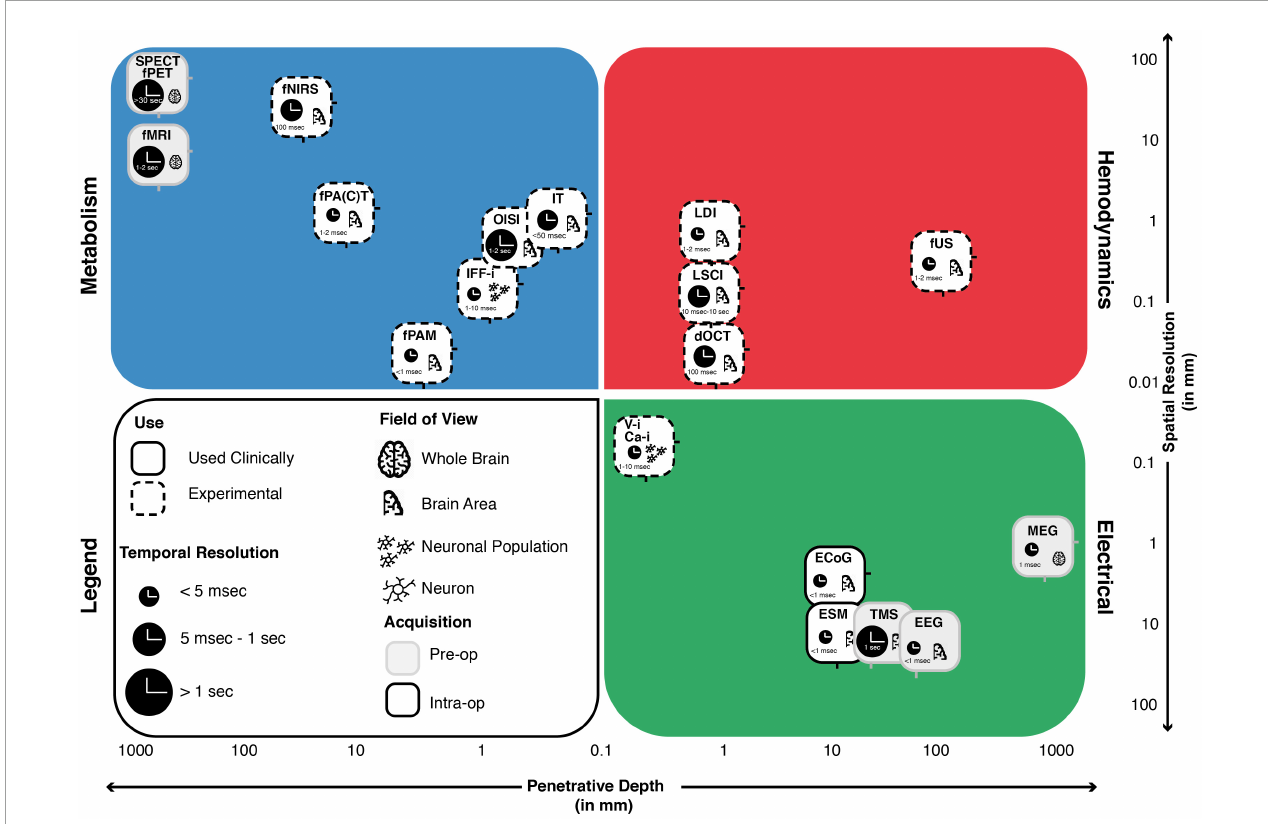
FIGURE3 The landscape of intra-operative functional imaging techniques and their respective technical characteristics. Metabolism-, Electrical- and Hemodynamics-based techniques are placed within a grid spanning spatial resolution ( y -axis) and penetrative depth ( x -axis). The techniques field of view, current status of use, intra-operative applicability and temporal resolution are also taken into considerations. Many of the techniques illustrate a trade-off between penetrative depth and spatial resolution, with high penetration, lower resolution techniques such as SPECT and fPET on the one end and low penetration, high resolution techniques such as V-i and Ca-i on the other end of the spectrum. Unique positions within the domain are taken up by techniques such as MEG, which is able to combine full brain penetration with good spatiotemporal resolutions. A similar position is taken up by fUS, which combines sufficient penetration depths with exceptional spatiotemporal resolution, while showing actual intra-operative applicability. ECoG, electrocorticography; EEG, electroencephalography; MEG, magnetoencephalography; ESM, electrocortical stimulation; Ca-i, calcium-imaging; V-i, voltage-imaging; TMS, transcranial magnetic stimulation; NVC, neurovascular coupling; PAI, photo-acoustic imaging; fNIRS, functional near-infrared spectroscopy; dOCT, Doppler optical coherence tomography; fUS, functional ultrasound; LDI, laser Doppler imaging; LSCI, laser speckle contrast imaging; RBC, red blood cells; NMC, neurometabolic coupling; IFF-I, intrinsic functional fluorescence-imaging; IT, infrared thermography; OISI, optical intrinsic signal imaging; fMRI, functional magnetic resonance imaging; fPET, functional position emission tomography; SPECT, single-photon emission computed tomography; Pre-op, pre-operatively available only; Intra-op, intra-operatively